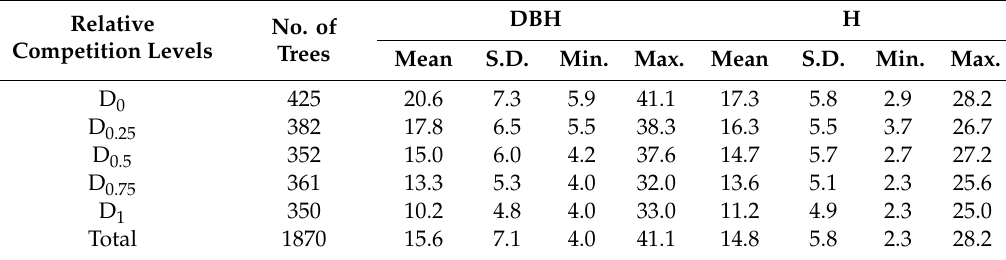
Table 2. Summary statistics of trees for each relative competition levels without trees in buffer. Relative